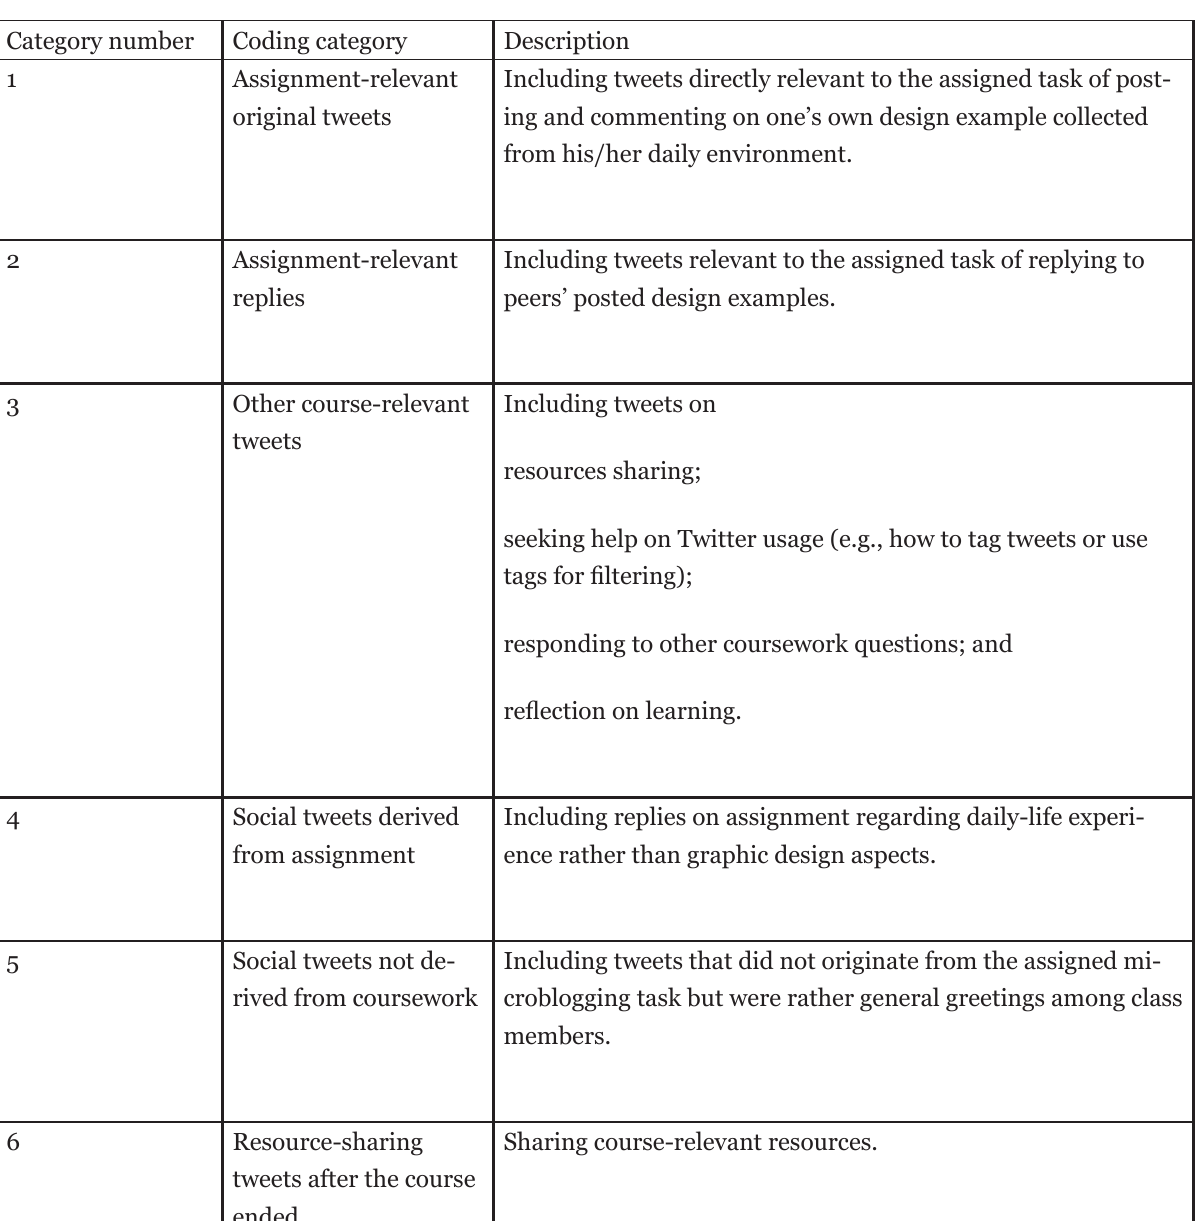
Table 1 Tweet Coding Category and